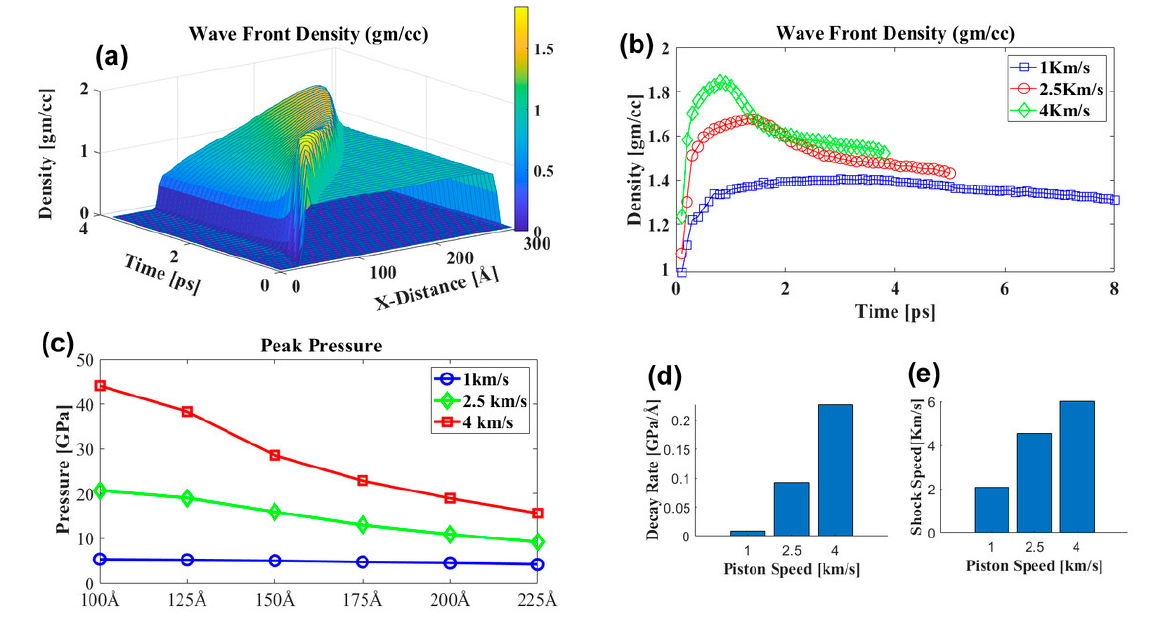
Figure 7. ( a ) Shock wavefront density at different piston speeds. The inset plot shows the piston speed’s corresponding shock velocity. ( a , b ) Density distribution during the shock propagation at different locations and times for 4 km/s piston speed, the color bar represents density variation along the shock direction. ( b ) Shock wavefront density at different piston speeds. ( c ) Peak pressure at different locations along the x-axis during the shock propagation at different shock speeds. ( d ) shows the maximum pressure decay rate at different shock speeds represented in ( c ). ( e ) shows the piston speed’s corresponding shock velocity.